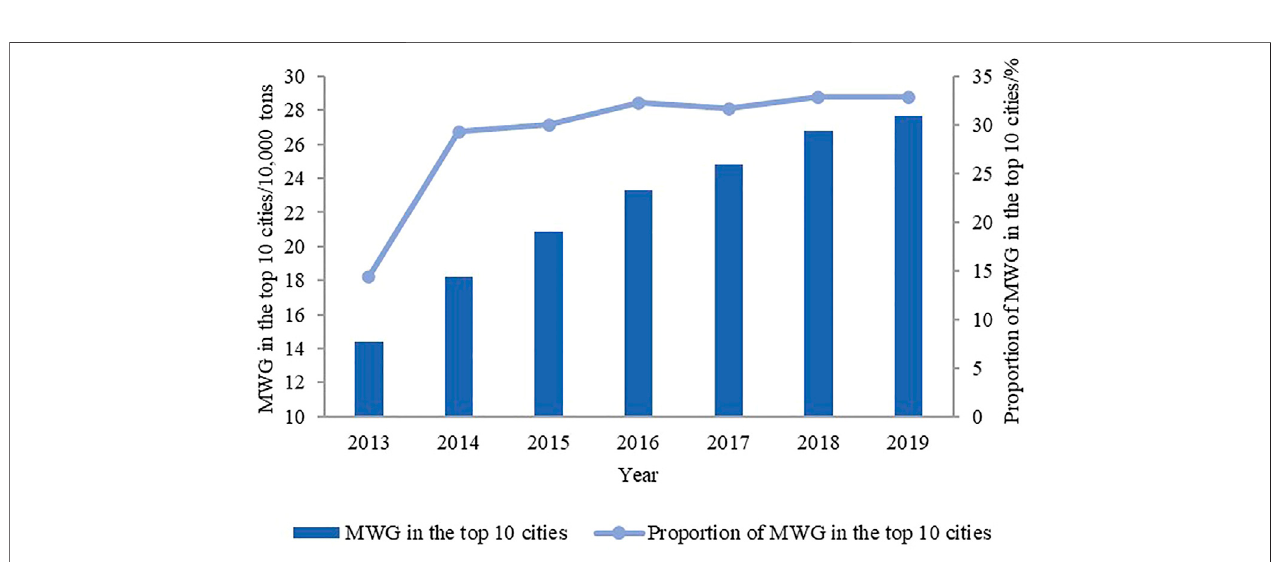
FIGURE 2 | The amount and proportion of MWG in the top 10